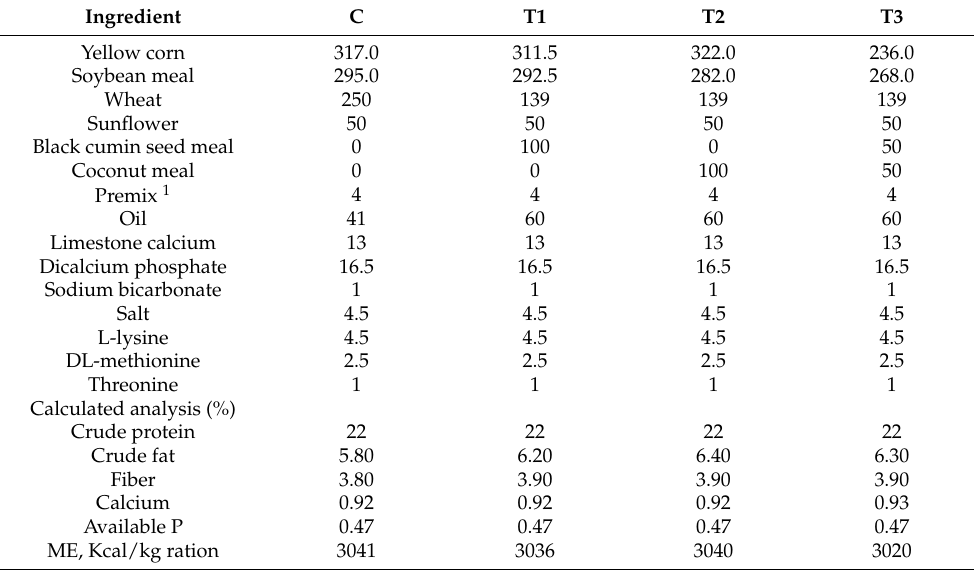
Table 1. Composition of the starter diets fed to broilers in four feeding trials, g/kg. Ingredient C T1 T2 T3 Yellow corn